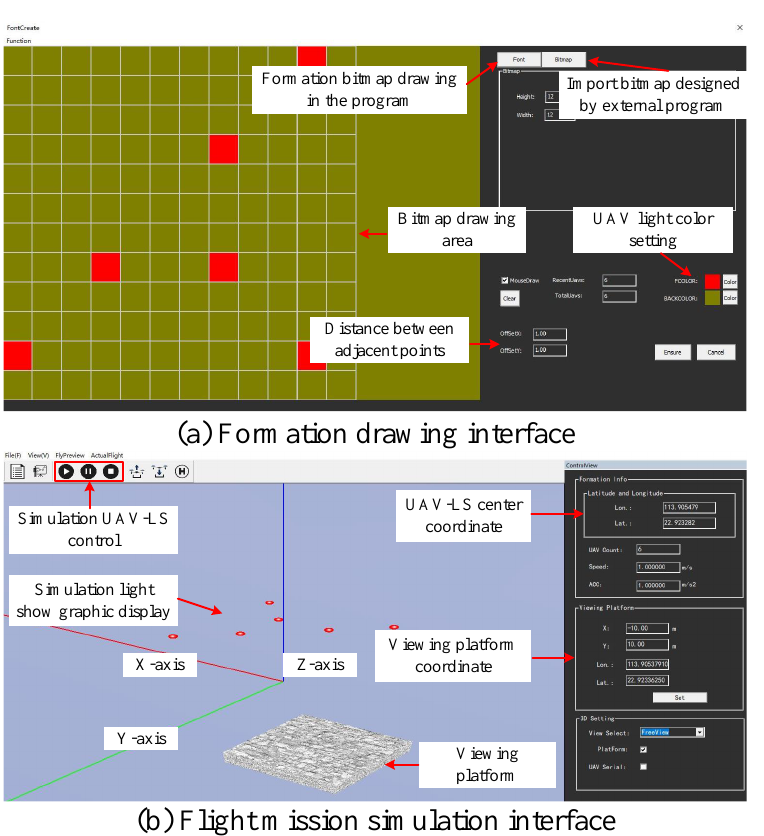
Figure 6. Animation design Interface.